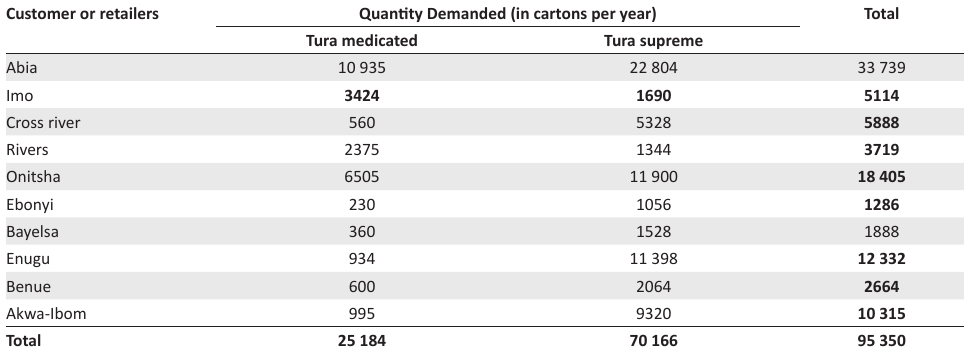
table with the corrections given in bold: TABLE 2: Quantity demanded by customers from depot or warehouse Customer or